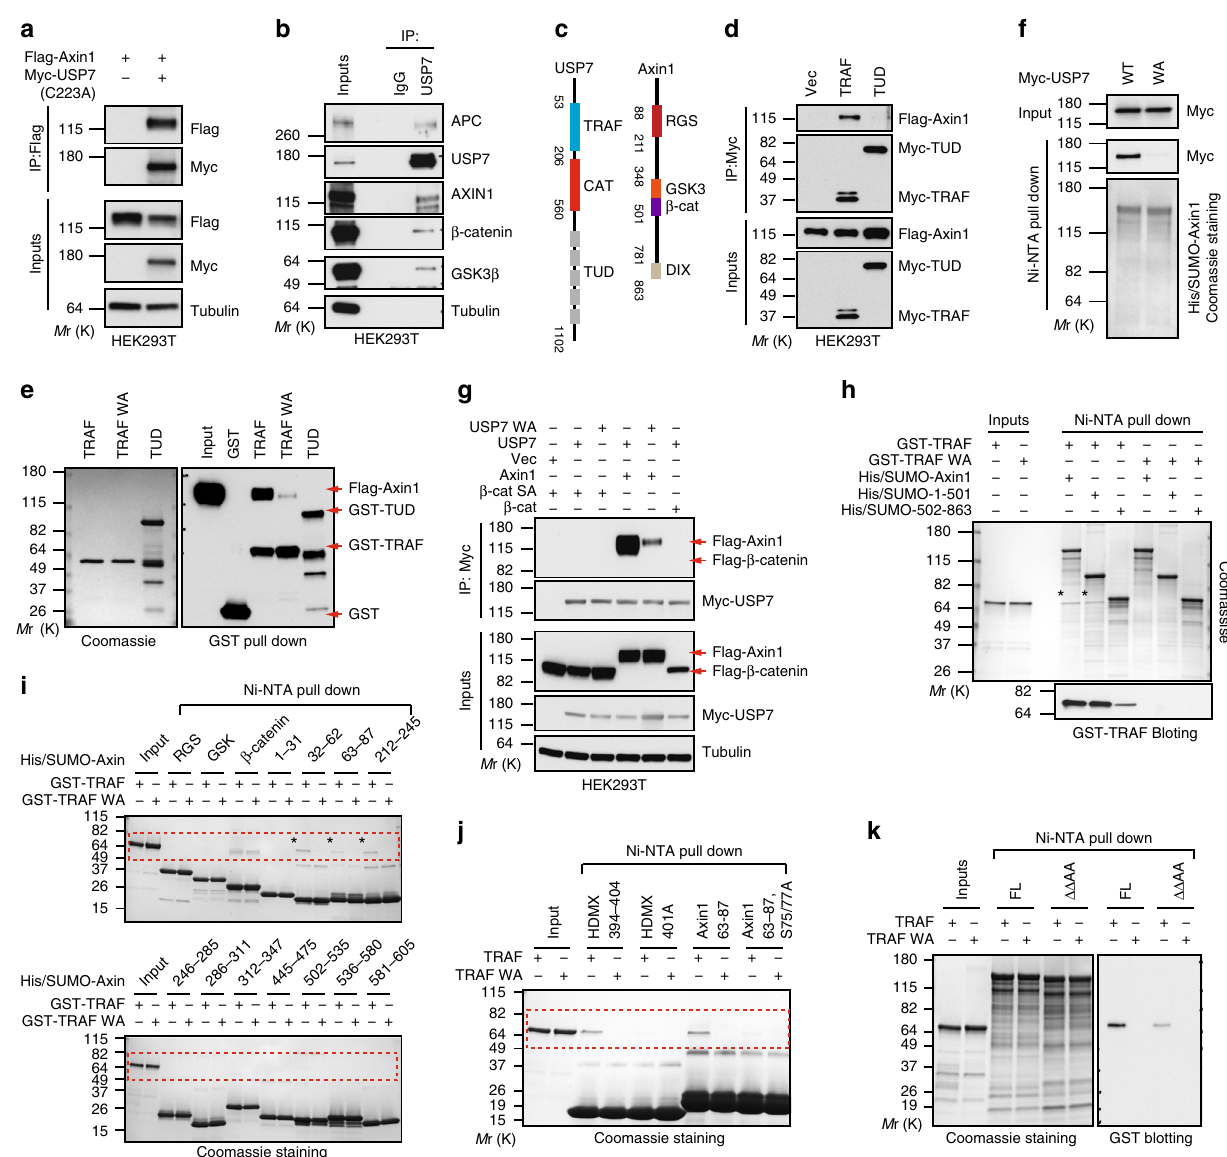
Fig. 4 USP7 directly binds to Axin through its TRAF domain. a Ectopically expressed Axin1 and USP7 C223A mutant interact with each other in co- immunoprecipitation assay. b Endogenous AXIN1 and other major components of β -catenin destruction complex are co-immunoprecipitated with endogenous USP7 in the co-immunoprecipitation assay. c Schematic diagrams of Axin1 and USP7 proteins. d Ectopically expressed TRAF domain, but not TUD domain, of USP7 interacts with Flag-Axin1 in co-immunoprecipitation assay. e Puri fi ed recombinant GST-TRAF, but not GST-TRAF W165A mutant or GST-TUD, interacts with ectopically expressed Flag-Axin1 in GST pulldown assay. Quality of GST fusion proteins was determined by coomassie staining (left panel) and pulled down proteins were revealed by immunoblotting with Flag and GST antibodies (right panel). f Puri fi ed recombinant His-SUMO- Axin1 selectively interacts with ectopically expressed wild-type Myc-USP7, but not Myc-USP7 W165A mutant, in Ni-NTA pulldown assay. g Interaction between ectopically expressed Flag-Axin1 or Flag- β -catenin and Myc-USP7 in co-immunoprecipitation assay. h Puri fi ed His-SUMO tagged full-length and the N-terminal fragment (a.a.1 – 501) of Axin1 exhibit similar binding to puri fi ed GST-TRAF in Ni-NTA pulldown assay. Pulled down GST-TRAF proteins are denoted by asterisks. i Interaction between small fragments of Axin1 and USP7-TRAF domain in Ni-NTA pulldown assay. Three small fragments of Axin1 selectively interacting with GST-TRAF are denoted by asterisks. j S75/77 A mutation attenuates the interaction between puri fi ed His-SUMO-Axin1 a. a. 63 – 87 and GST-TRAF protein in the Ni-NTA pulldown assay. His-SUMO-HDMX a.a. 394 – 404 and its S401A mutant serve as positive and negative control respectively. k Axin1 mutant ( ΔΔ AA) with deletion of a.a. 32 – 62 and a.a. 212 – 245 and mutation of S75/77 shows reduced interaction with GST- TRAF as compared with full length Axin1 (FL). Protein quality was determined by coomassie staining, and pulled down GST-TRAF was revealed by immunoblotting with anti-GST antibody. Source data for Fig. 4a, b, d, e, f, g, h, i, j and k are provided as Source Data fi (Fig. 6b) and the expression of β -catenin target gene Axin2 in catenin signaling blocks adipocyte differentiation, Usp7 the presence of adipocyte differentiation medium (Fig. 6c, lower knockout strongly inhibited adipocyte differentiation medium- panel). These results suggest that USP7 knockout increased induced lipid droplet formation (Fig. 6c, upper panel) and Wnt/ β -catenin signaling in cells treated with adipocyte differ- expression of adipogenic markers such as Pparg , Fabp4 , and Lpl entiation medium. Consistent with the notion that Wnt/ β - (Fig. 6c, lower panel).